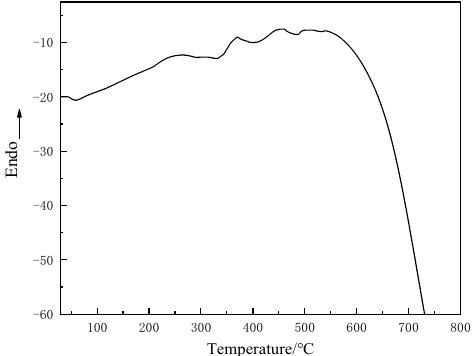
Figure 9. DSC curve of T26 polyurea in a wide temperature range up to high temperatures.